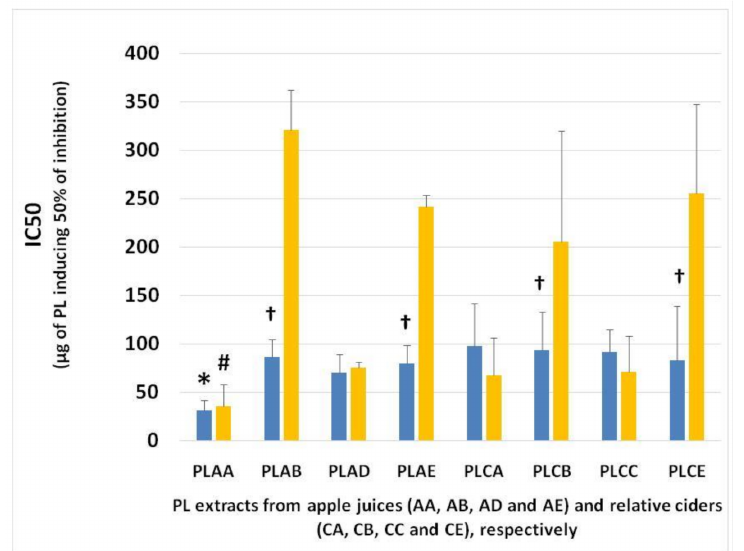
Figure 3. Antiplatelet activities of PL extracts from different apple juice and cider samples against human platelet aggregation induced by PAF and ADP. The blue bars represent the IC50 values of PL extracts against the PAF pathway, and the yellow bars indicate the IC50 values against ADP pathway of platelet aggregation. * denotes statistically significant difference ( p < 0.05) of the anti- PAF potency (IC50 value) of apple juice AA in comparison to the relative IC50 values of PL from all the other samples tested against PAF-induced aggregation of platelets. # denotes statistically significant difference ( p < 0.05) of the anti-ADP potency (IC50 value) of apple juice AA in comparison to the relative IC50 values of PL from all the other samples tested against ADP-induced aggregation of platelets. † denotes statistically significant difference ( p < 0.05) of the anti-PAF potency (IC50 value against PAF) of a sample in comparison to its anti-ADP effects (IC50 value against ADP). Abbreviations: PL: polar lipids; AA and CA: apple juice and cider from apples with low content in tannins (Jonagold), respectively; AB and CB: apple juice and cider from apples with moderate content in tannins (Dabinett); AE and CE: apple juice and cider from apples with high content in tannins (Aston Bitter); AD: commercially found apple juice (relevant to the apple juice AA of the Jonagold variety); CC: commercially found cider ‘ Con’s Irish Cider ® ’ (produced by fermentation of a mixture of the aforementioned three different apple juice types in a ratio of 55% Jonagold, 35% Dabinett and 10% Aston